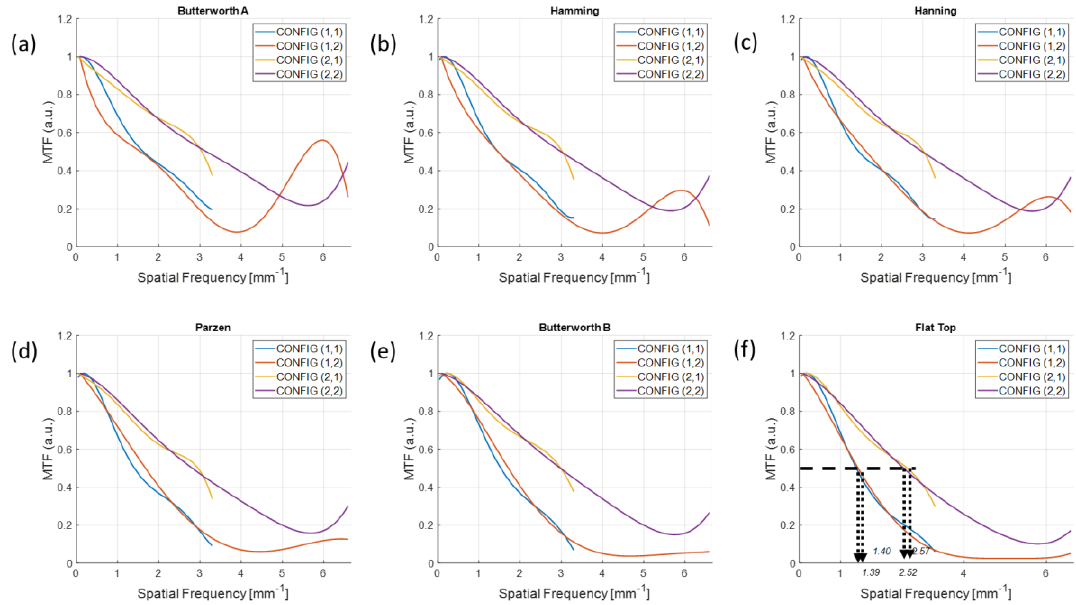
Figure 9. Modulation transfer functions (MTFs) for different filter schemes from the ( a ) Butterworth A, ( b ) Hanning, ( c ) Hamming, ( d ), Parzen, ( e ) Butterworth B, and ( f ) Flat Top windows with different configurations. The f 50 s measured in the images implemented with the flat top window were 1.39, 1.40, 2.52, and 2.57 lp/mm for the configuration (1, 1), (1, 2), (2, 1), and (2, 2), respectively.